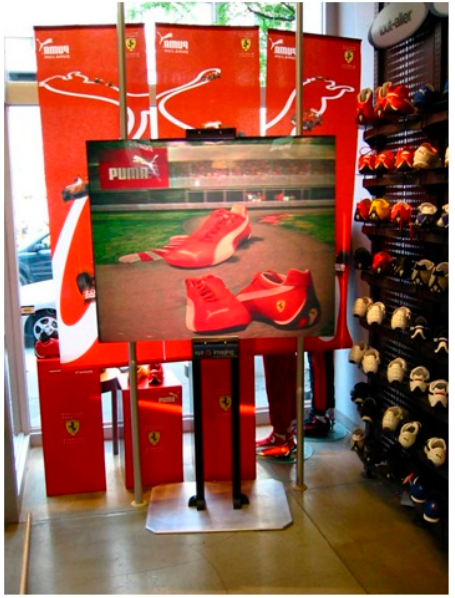
Figure 6. Digital holographic print of Ferrari shoes, 2005. (Courtesy Geola Digital UAB.)